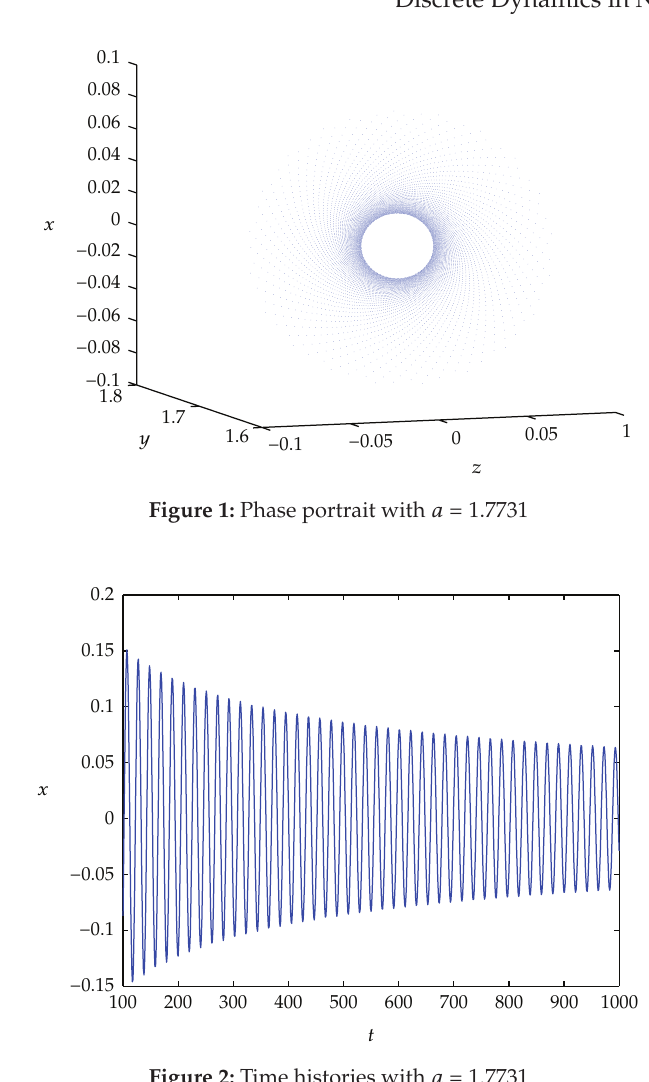
Figure 2: Time histories with a (cid:7) 1 .